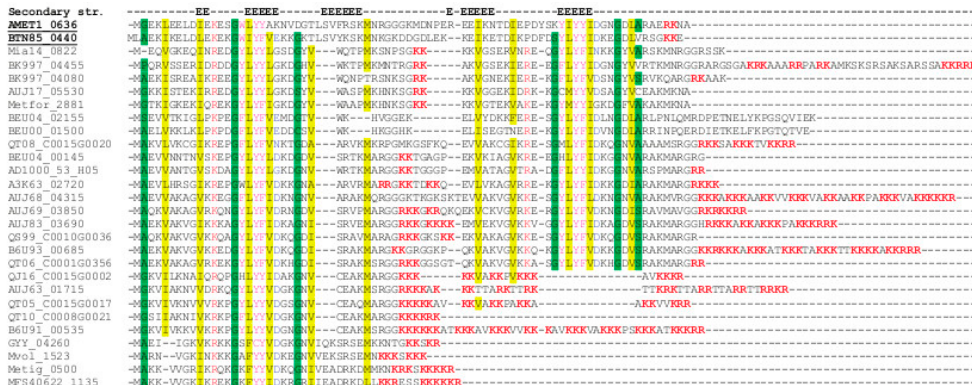
Figure 2. Multiple alignment of the predicted novel RNA chaperones. Multiple alignment is shown for selected archaeal representatives of the putative RNA chaperone family (see the complete list of homologs in the Table S2). The sequences are denoted by their locus tag numbers. Two underlined locus tag numbers correspond to M. thermophilum AMET1 and HMET1. Secondary structure elements are shown above the alignment, with “E” indicating positions predicted to be in a beta strand. Amino acids in the conserved (80%) positions are coloured according to their physico-chemical properties as follows: yellow background indicates aliphatic residues (I,L,M,V), green background indicates small residues (A,G,P,S), red letters indicate positively charged residues (K,R), blue—indicate negatively charged residues (D,E,N,Q), magenta-aromatic residues (F,Y,W). Patches of positively charged residues are highlighted in bold red font.